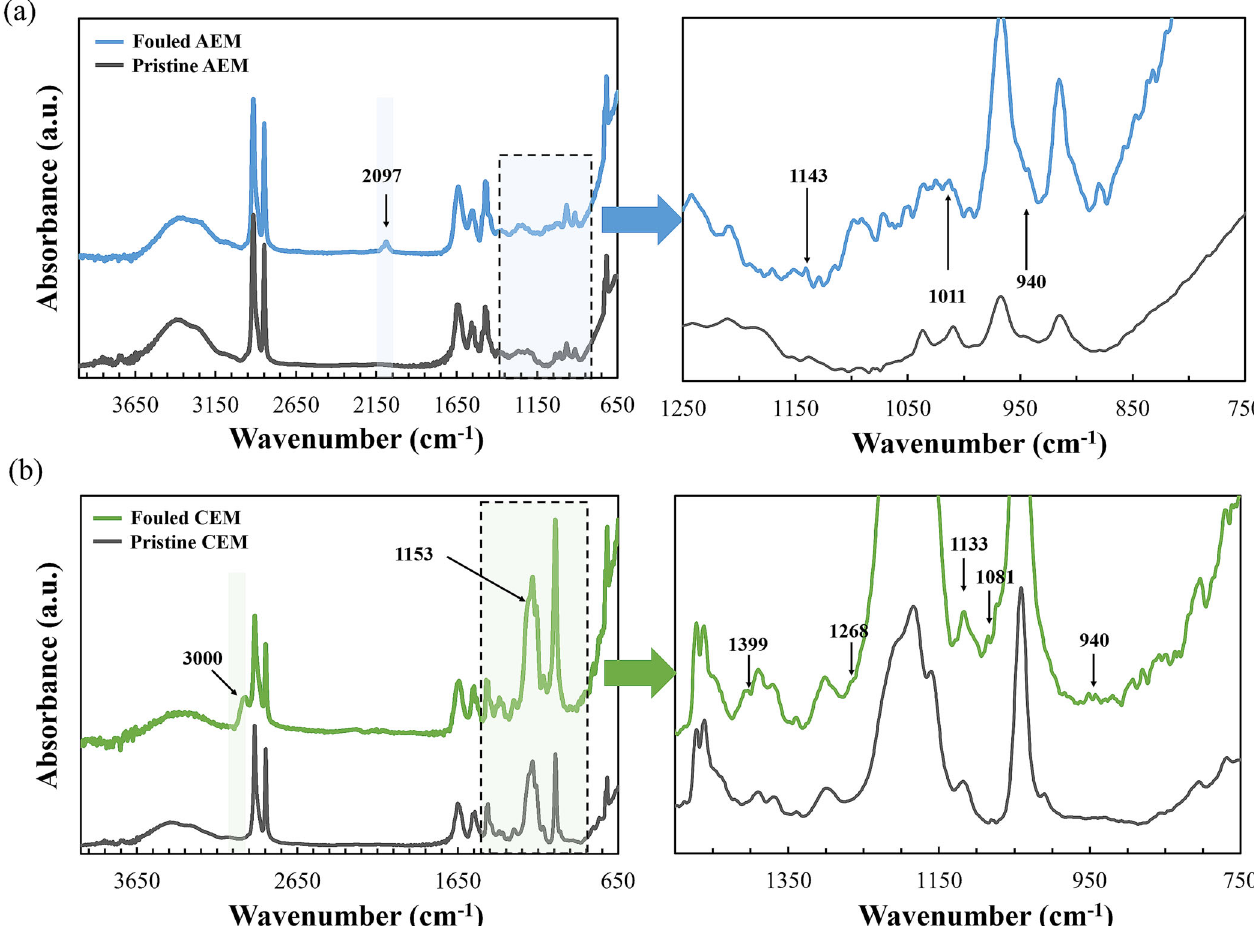
Fig. 7 ATR-FTIR spectra of the pristine and fouled fl at membranes after continuous RED operation. a, b Show ATR-FTIR spectra of AEM and CEM.